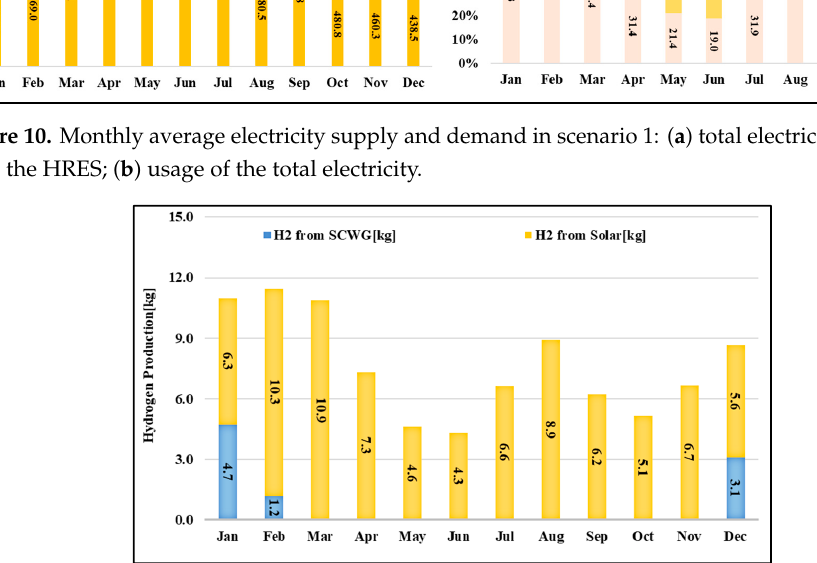
Figure 11. Monthly average hydrogen production in scenario 1.